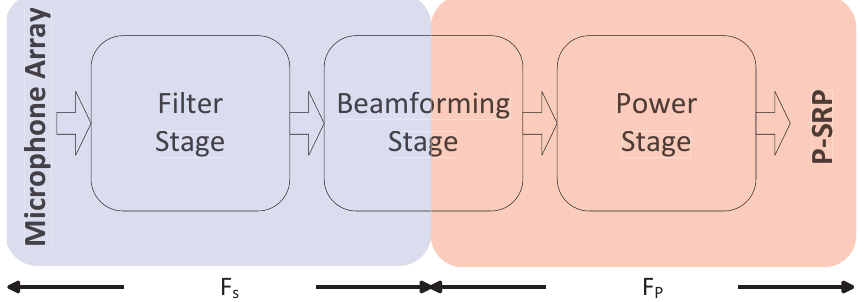
Figure 5. The proposed architecture operates at two different clock rates to achieve real-time acoustic